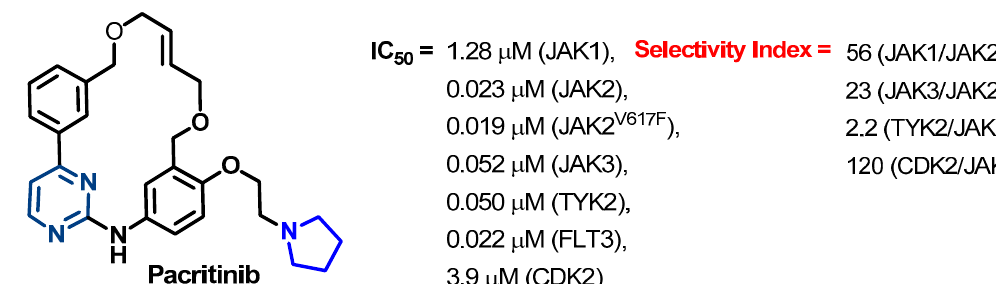
Figure 40. Kinase inhibitory activities of pacritinib.